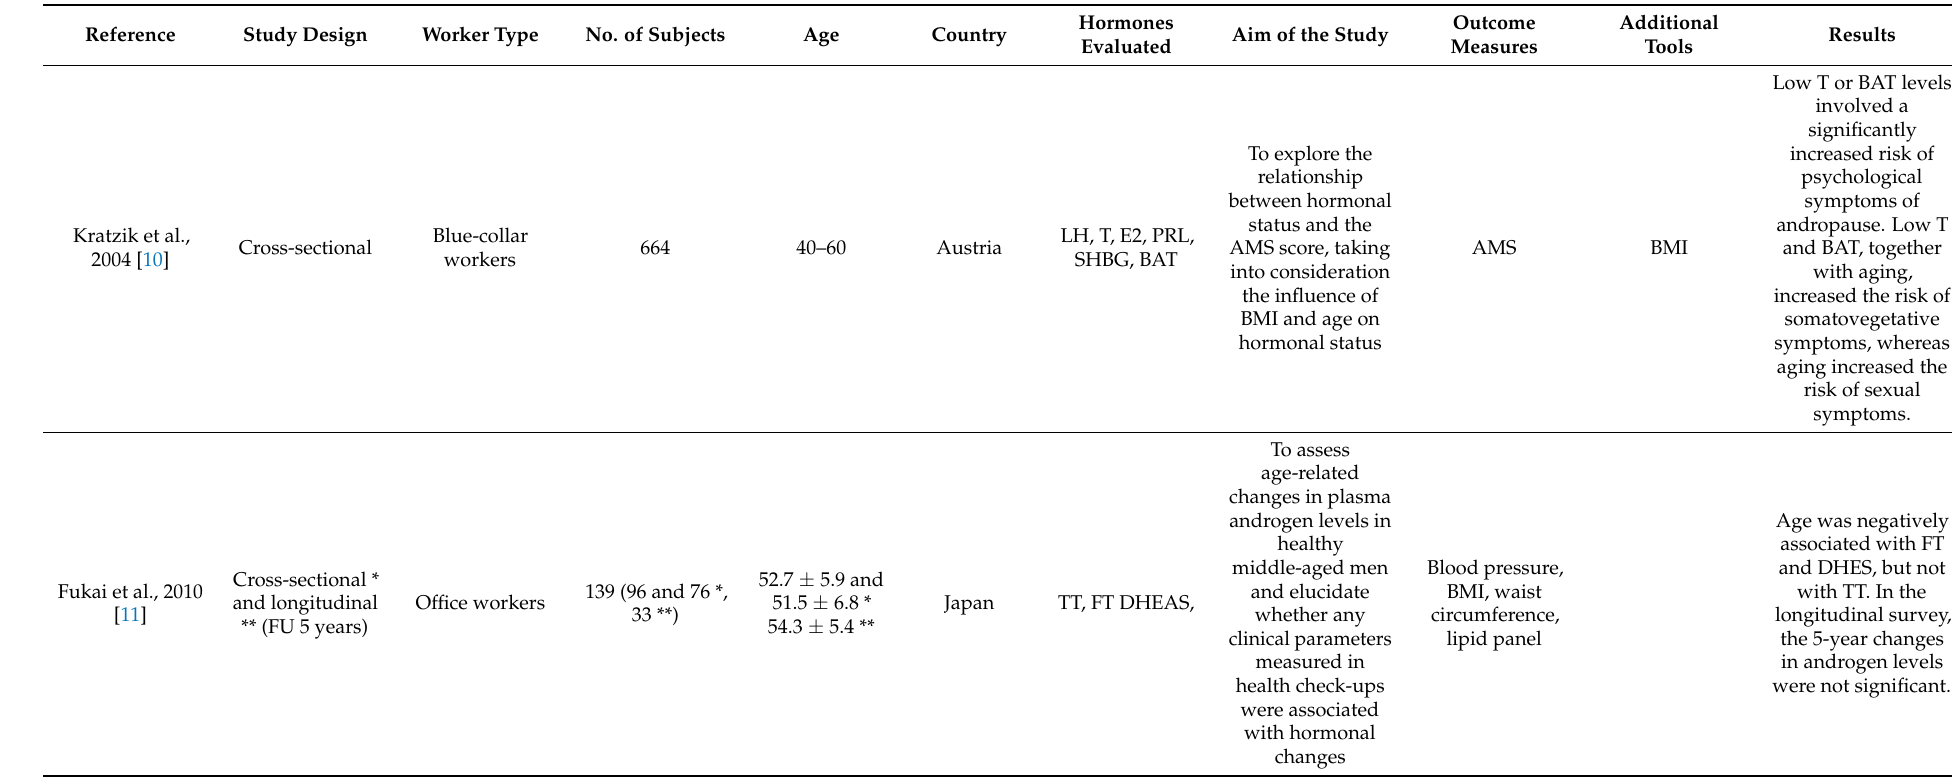
Table 2. Studies evaluating work and